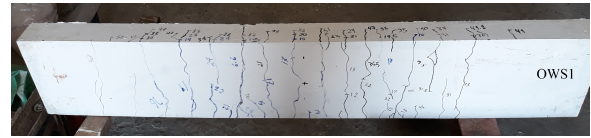
Figure 14: Bottom crack pattern of slab